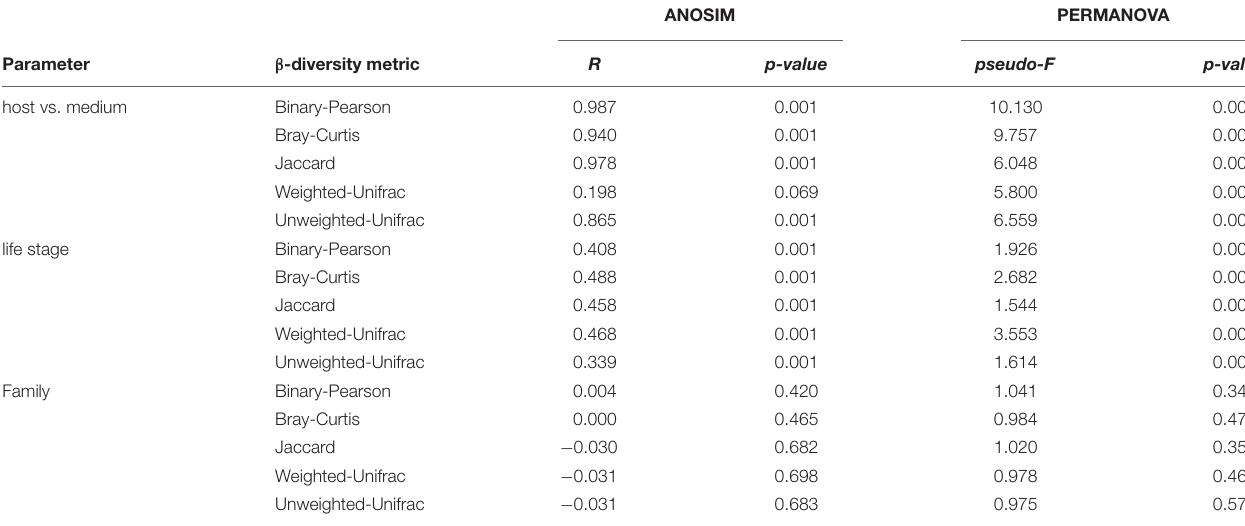
TABLE 1 | Beta-diversity statistical tests comparing the different sample sources, the developmental stages and the families.